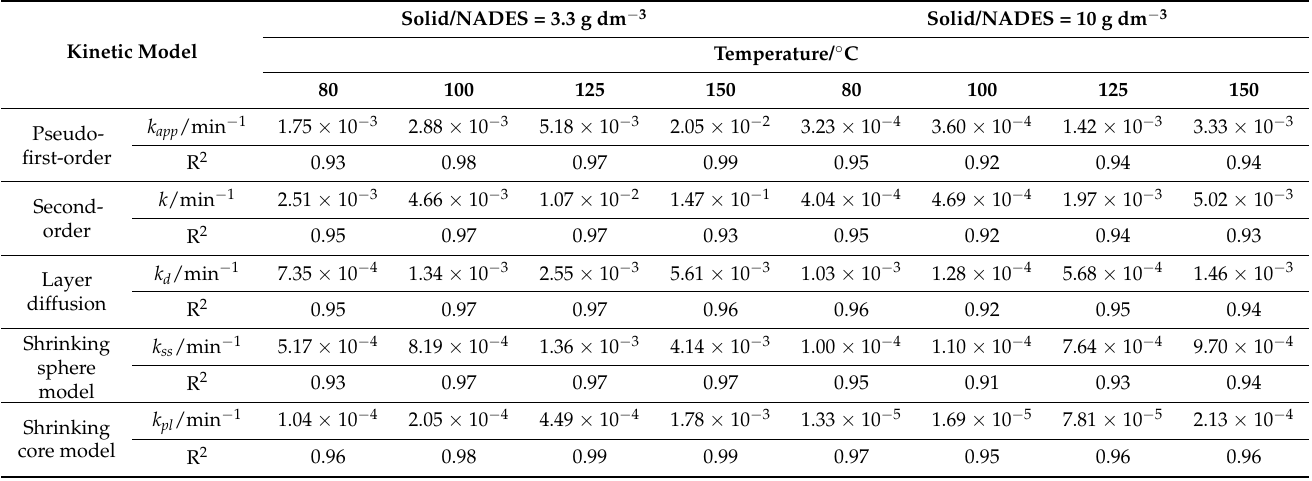
Table 2. Kinetic Parameters and fitting for Zn oxide leaching as a function of temperature. solid/NADES = 3.3 and 10 g dm − 3 .